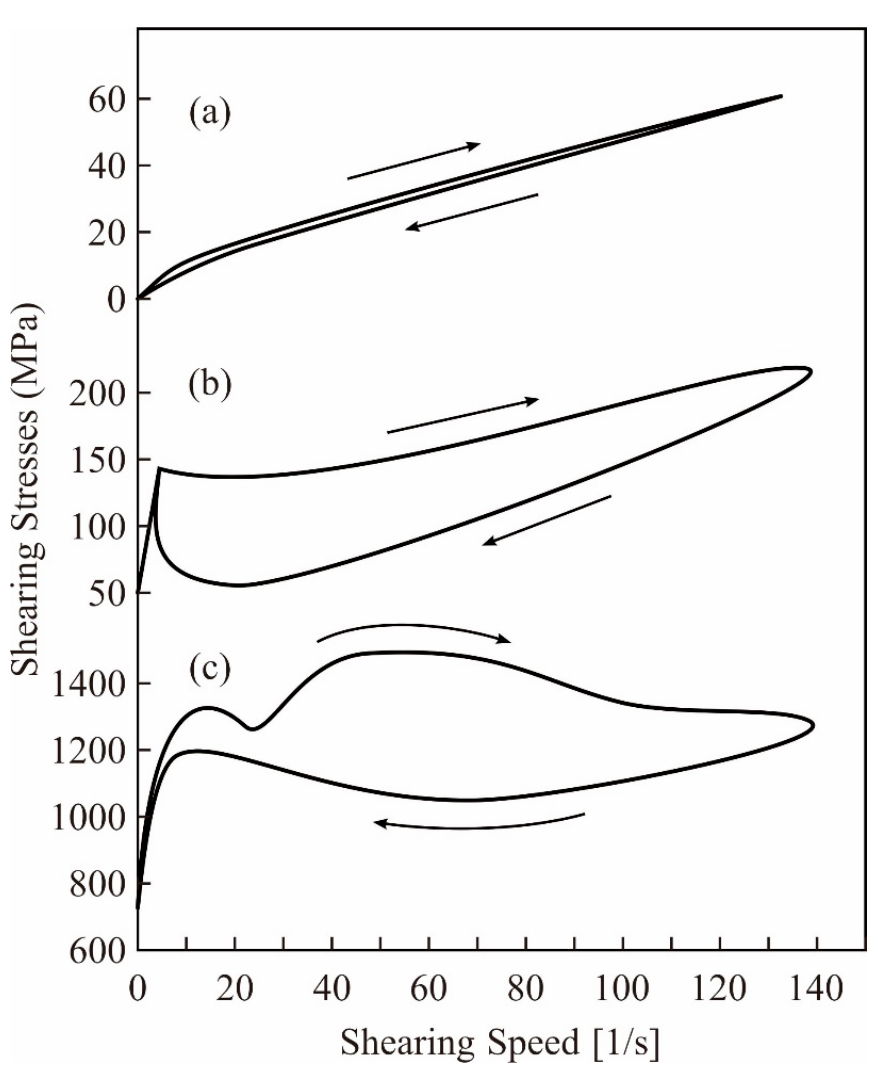
Figure 7. Dynamic profiles of shearing stresses and speeds. Rheological profiles were analyzed by a kinematic viscometer (KV). Viscose pastes processed for 300, 600, and 900 s are shown in (a); (b), and (c), respectively.